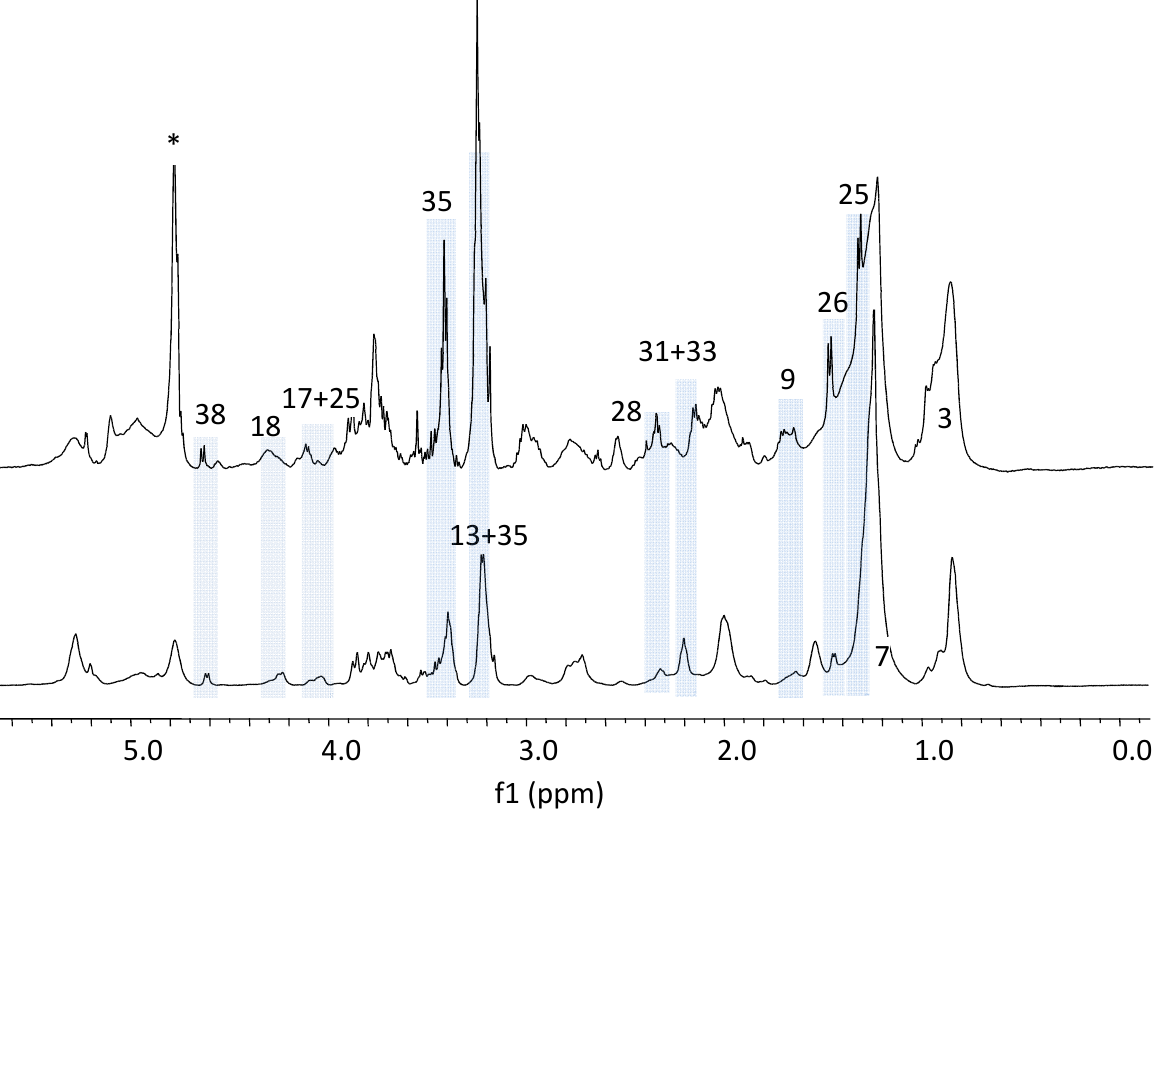
Figure 1. Representative 1 H HR-MAS NMR Spectra of Intact Livers. Bottom trace: ; 7.Lipids (CH ) ; 9.Lipids Control; Top trace: Tumor. Spectral assignments: 3.Lipids CH 3 2 n CH CH CO; 13.Choline N(CH ) ; 25.Lactate; 26.Alanine; 28.Glutamate; 31.Glutathione; 2 2 3 3 33.Creatine + Creatinine; 35.Taurine; 38. β -Glucose. “*” denotes residual water signal. The doublets from lactate (d, J = 7.8 Hz) (peak “25”) and alanine (d, J = 7.7 Hz) (peak “26”) are the sharpest peaks in the spectra of melanoma liver, but their relative spectral intensities are much lower and their peak widths are much broader in the spectra of the control group when using lipid peak 7 at 1.28 ppm as the intensity reference. The relative intensities of peaks 13 (choline), 17 (glycerol ester), 18 (phosphatidylcholine), 25 (lactate), 26 (alanine), 28 (glutamate) and 35 (taurine) are much higher in the metastatic melanoma group). Then grey group than the ones in the control group with peak 7 (lipid CH 2 rectangular areas in the Figure highlight those metabolites that are discussed in the